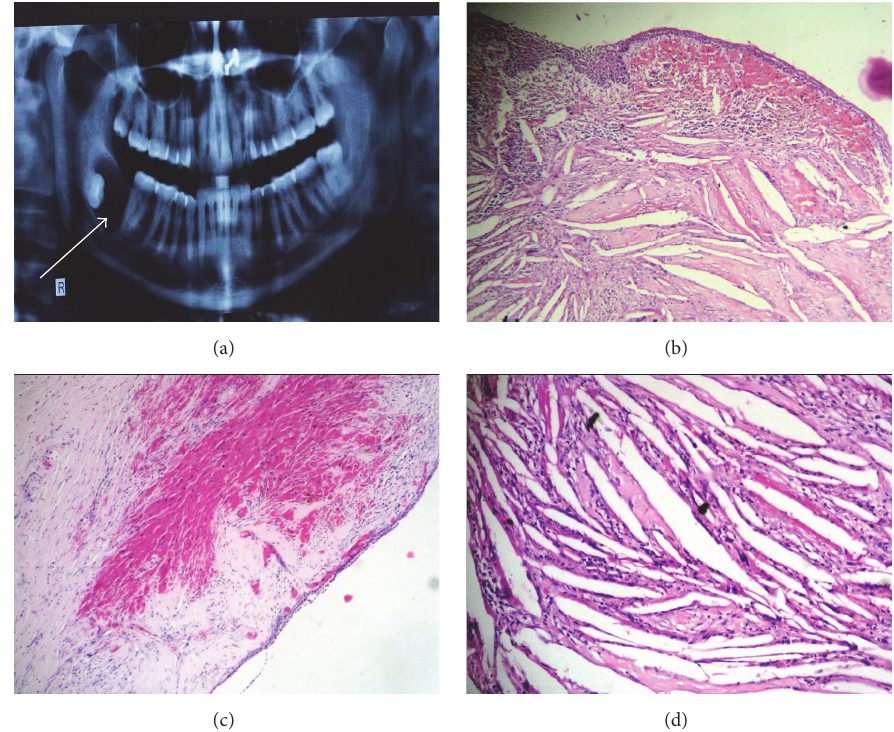
Figure 2: (a) An OPG showing a well-defined radiolucency in relation to crown of 48; (b) nonkeratinized stratified squamous cystic epithelial lining which showed proliferation in few areas associated with underlying cholesterol clefts and extravasated RBCs in the cystic wall (H/E 4x); (c) cystic lining with abundant area of hemorrhage in the cystic wall (H/E 4x); (d) cholesterol clefts in cystic wall (H/E